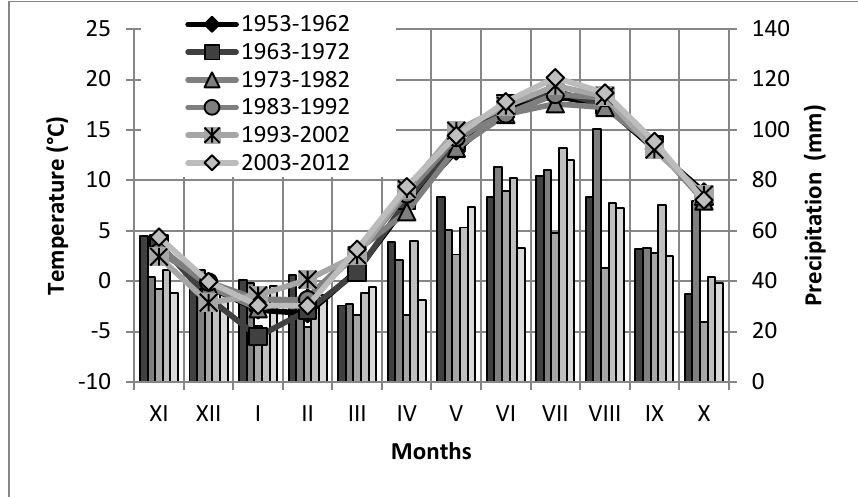
Figure 7. Average monthly precipitation (bars) and air temperature (lines) in selected decades.